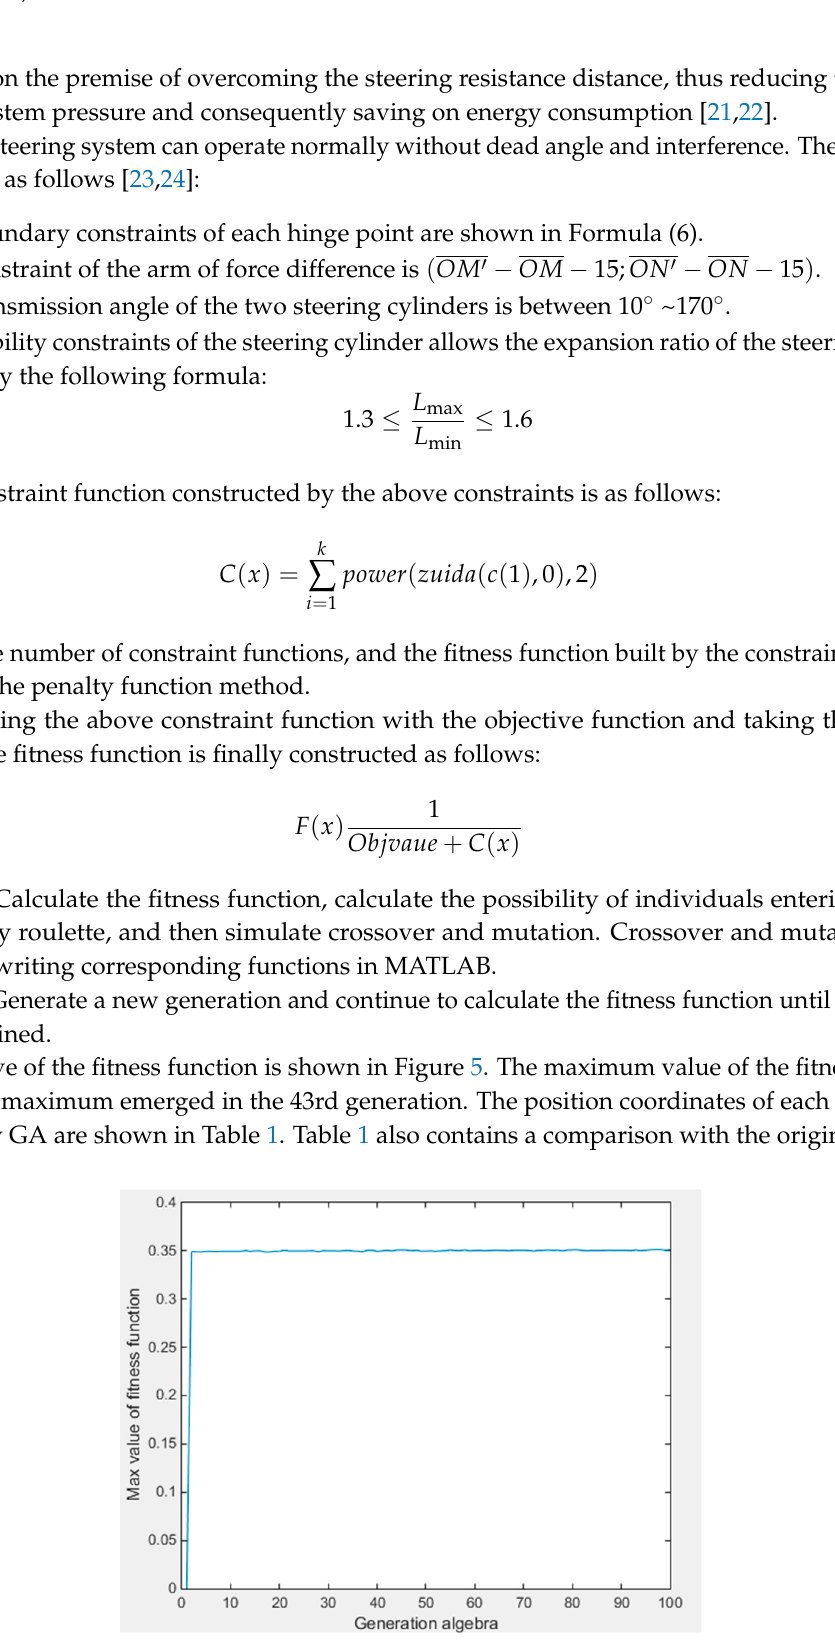
Figure 5. The fitness function. Table 1. The coordinates of articulated points optimized by GA.